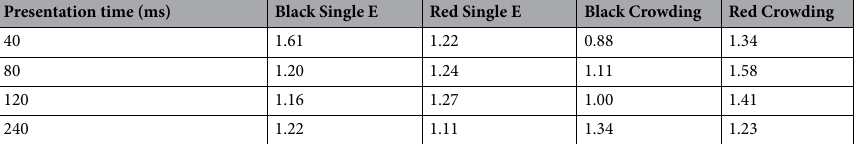
Table 1. Binocular summation ratio for all presentation time under all